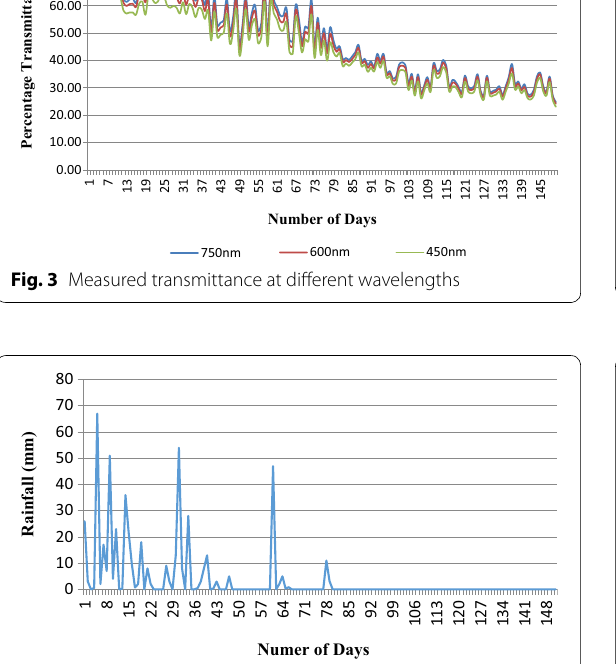
Fig. 7 Power output from clean and dusty solar